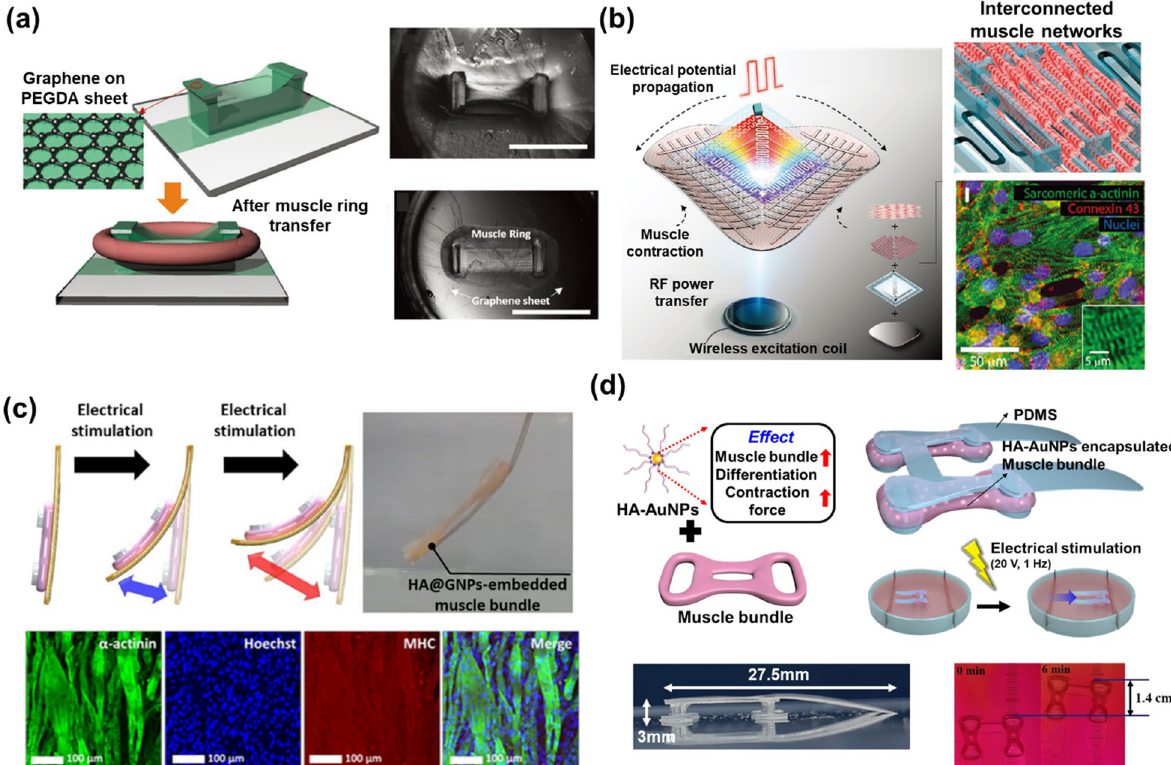
Fig. 6 a Schematic diagram of a conductive hydrogel electrode with a 3D tissue model for the application of electrical stimulation to induce muscle contraction. Reproduced with permission from [104], copyright John Wiley and Sons, 2020. b Schematic diagram of a wirelessly powered 3D‑printed hierarchical biohybrid robot composed of four parts: (i) A CNT/GelMa hydrogel layer for the elastic body, (ii) stretchable wirelessly‑powered bioelectronics for cell stimulation, (iii) 3D‑printed accordion‑inspired scaffolds, and (iv) iPSC‑derived muscle tissues. Reproduced with permission from [106], copyright John Wiley and Sons, 2022. c Schematic diagram of the actuation process of an electroactive nanobiohybrid actuator composed of